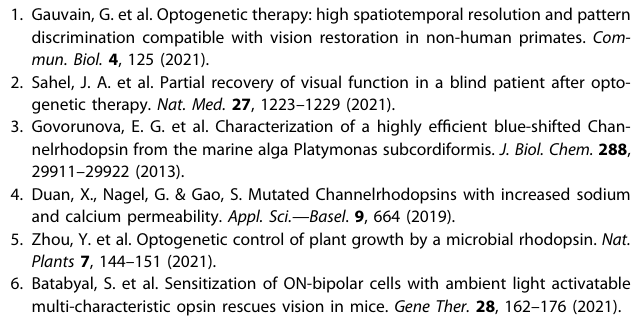
Fig. 1 The characterizations of PsCatCh2.0, and the ef fi ciency for vision restoration by optogenetics in rd1 mice. a Scheme of Ps CatCh2.0 and representative photocurrent traces of CatCh and Ps CatCh2.0 measured by two-electrode voltage clamp (TEVC) in Xenopus oocyte. b Stationary photocurrents of CatCh, Ps CatCh and Ps CatCh2.0 illuminated by different intensities of blue (450 nm) light. n = 3. c Representative photocurrent traces of CatCh and Ps CatCh2.0 in 80 mM CaCl 2 pH 9.0 buffer with (both top traces) and without 10 mM BAPTA injection, holding at − 100 mV. d Comparison of the CatCh and Ps CatCh2.0 calcium current. n = 6 – 7. e Fluorescence pictures (left) of Ps CatCh and Ps CatCh2.0- expressing oocytes and fl uorescence emission values (right) of Ps CatCh and Ps CatCh2.0-expression oocytes. All measurements were done two days after injecting 20 ng cRNA into fresh oocytes. n = 4. f Representative image of whole-cell patch-clamp recording ganglion cell in Ps CatCh2.0-treated rd1 retinal slice, the light-evoked current traces of Ps CatCh2.0-expressed RGCs with 1 s light pulses at 470 nm under different light intensities measured as photons/cm 2 s. g The light intensity and current response relationship were measured at peak and plateau currents. n = 5. h Temporal properties of Ps CatCh2.0 in retina induced photocurrents at increasing stimulation frequencies at a light intensity of 2.7 × 10 16 photons/cm 2 s of 470 nm blue light. i Representative VEP waveforms. j Representative co-labeling of c-Fos (red), an immediate early gene, with GFP (green) in vertical retinal sections. k Representative co-labeling of light-induced immediate early genes c-Fos (red) and Arc (green) in the V1 area of the visual cortex. l Graphed VEP N1 amplitudes. n = 8. Representative result of counting positive cells of c-Fos or Arc in the retina ( m ) and V1-visual cortex ( n, o ), respectively. All mice experiments under the light intensity of 4.7 × 10 14 photons/cm 2 s of 470 nm blue light. One-way ANOVA test, ** P < 0.01, *** P < 0.001. Scale bars, 20 μ m ( j , k ). n = 5. p Representative traces of the fi rst time to fi nd the hole in light/dark box. q Percentage of time spent in the light compartment under a light intensity of 4.7 × 10 14 photons/cm 2 s. n = 11 – 19. r , d Representative distance and average velocity of the fi rst time to fi nd the hole in light/dark box, one-way ANOVA test, *** P < 0.001). t The average spatial acuity of mice (t-test, *** P < 0.001). Stimulus light intensity 4.7 × 10 14 photons/cm 2 s. All data showed mean ±